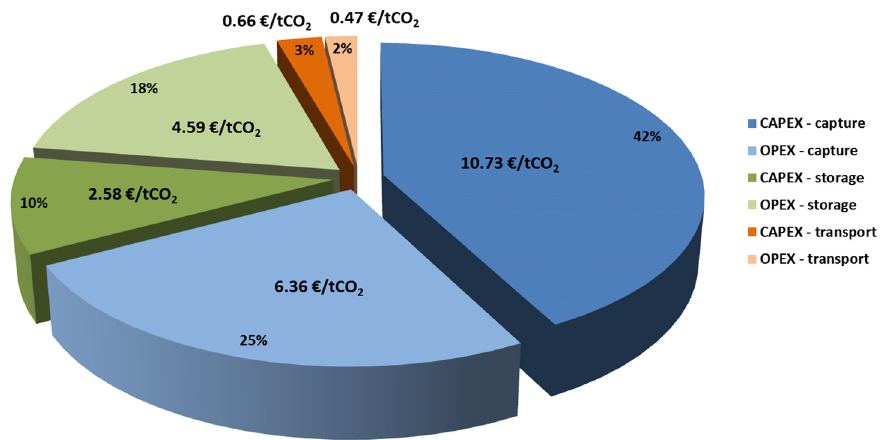
Figure 6. Graphical representation of CAPEX and OPEX in reference to 1 tonne of CO 2